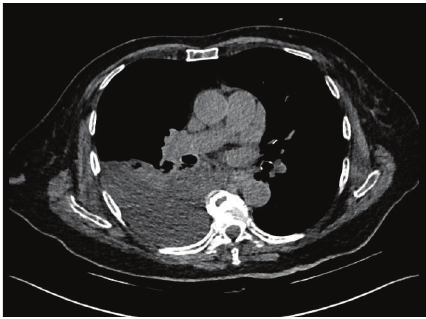
Figure 3: CT scan (MDCT, arterial with 40 mL Ultravist 370 and 5 min p.i. DLP 335 mGycm) of the thorax.